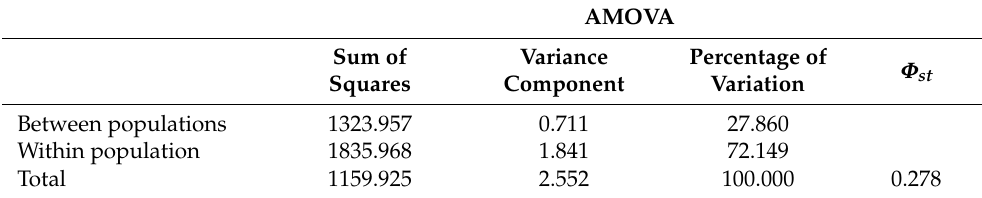
Table 5. Analysis of molecular variance (AMOVA) in 12 natural populations of Pseudotsuga menziesii (Mirb.) Franco.